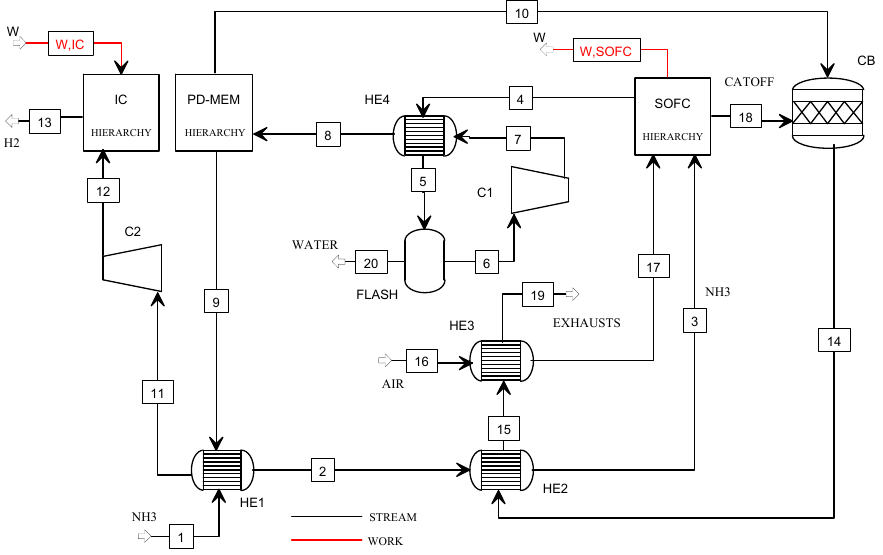
Figure 2. Flowsheet of the NH3_SOFC plant model. The ammonia (1) is preheated (HE1), vaporized (HE2), and sent to the SOFC power unit, where its decomposition occurs. The electrical power is produced at low fuel utilization factors so that the hydrogen content in the anode off-gas is high, and it can be used for the operation of the refuelling station. Thus, the anode off-gas (4) is fed to the Pd-membrane unit (PD-MEM) at its operating conditions in terms of pressure (4.2 bar) and temperature (400 °C). The purge gas (10) is mixed with the cathode off-gas (18) in the catalytic burner (CB), and the pure hydrogen (9) is delivered to the compression section. The hydrogen (11) is precompressed at 5 bar (C2) and, finally, stored at 900 bar using ionic compression unit. The exhausts from the CB are used to heat the ammonia (2) and